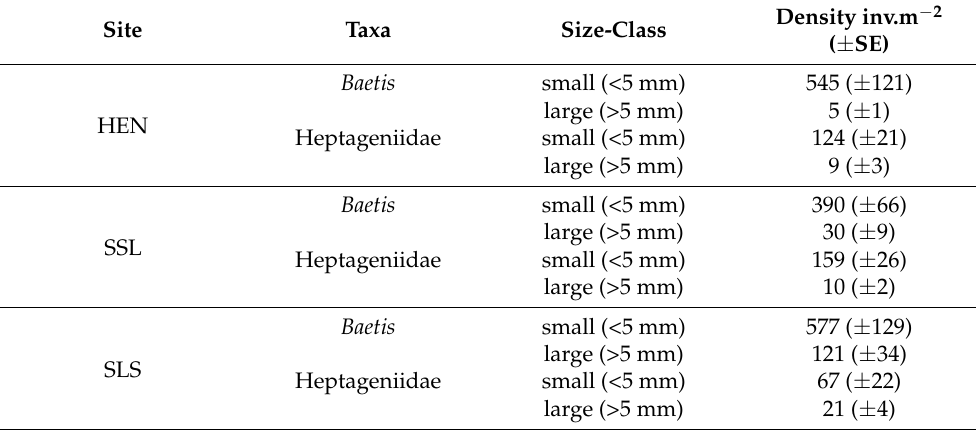
Table 4. Summary of the density of large and small Baetis and Heptageniidae